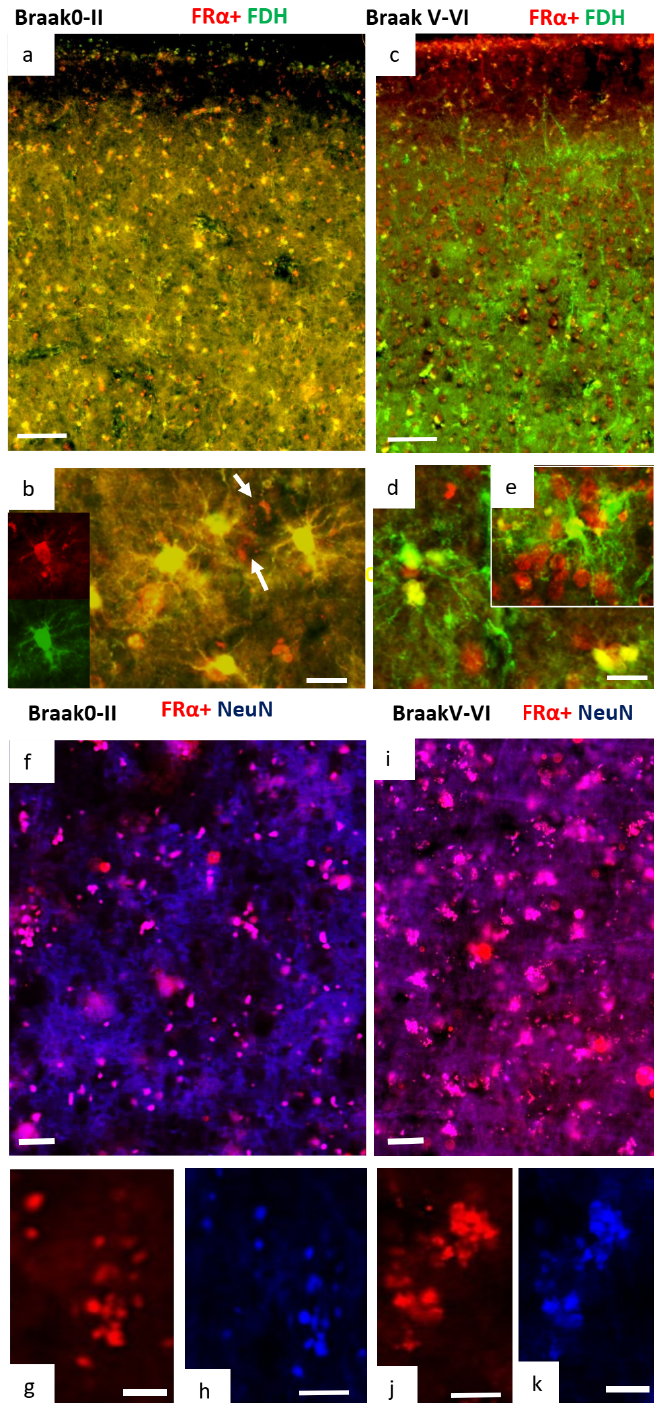
Figure 4. Immunofluorescence staining for FDH, FR α and NeuN. Double immunofluorescence staining for FR α (red) and FDH (green) in Braak 0-II ( a , b ) and Braak V-VI ( c – e ) brains (( a , c ) 100 × , scale:100 µ m and ( b ) 400 × , 20 µ m). Co-localisation (yellow) of FR α with FDH in the FDH-positive astrocytes in normal brains ( a , b ) shows almost complete separation in Alzheimer brain ( c – e ). FR α appears as speckled red staining in normal neuronal cell bodies (white arrows in ( b )) while in Alzheimer cortex these cells are full of red, FR α ( d , e ). Double immunofluorescence staining for FR α (red) and NeuN (blue) in normal ( f ) and AD ( i ) brains show colocalisation, which is shown in separate channels in ( g , h ) and ( j , k ) (( f ), 200 × , scale: 50 µ m (( g , h , j , k ), 400 × , scale: 20 µ m). The figure is representative of neurologically normal, Braak 0-II n = 3 and AD, Braak V-VI n =